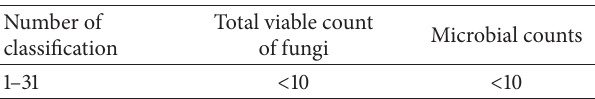
Table 3: Microbiological examination of local formulas in KSA (CFU/g −1 ) ∗